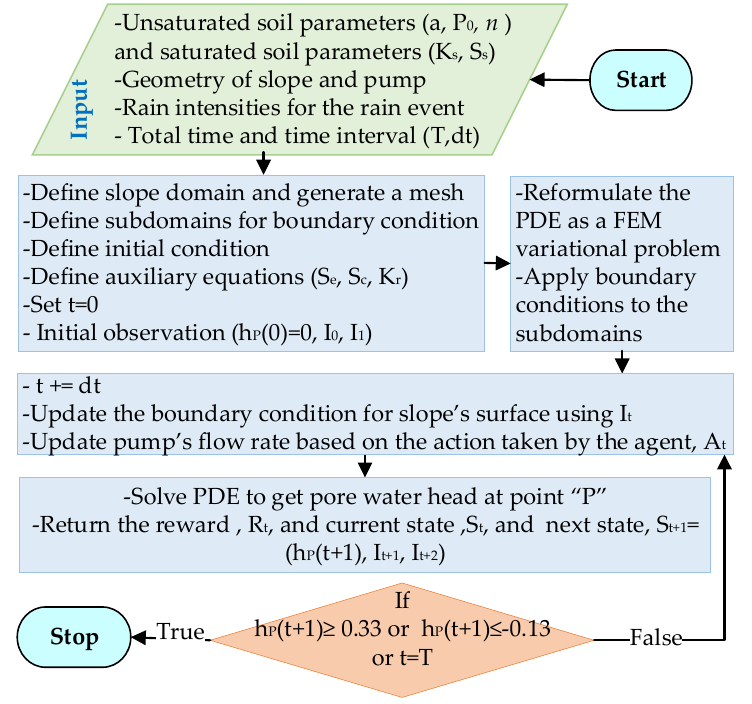
Figure 3. Flowchart of the developed Python code for the seepage model (i.e., virtual environment).